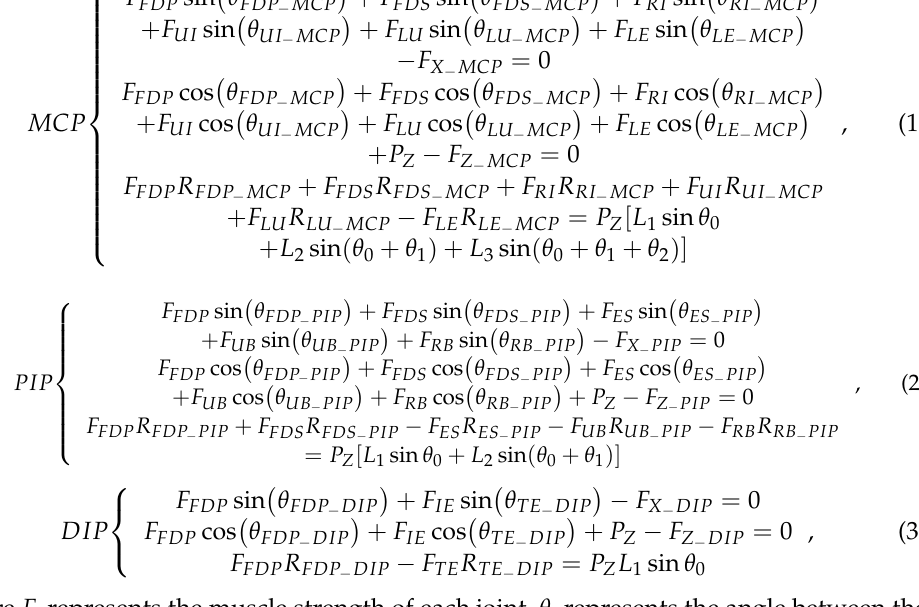
Figure 9. Finger biomechanical relationship.